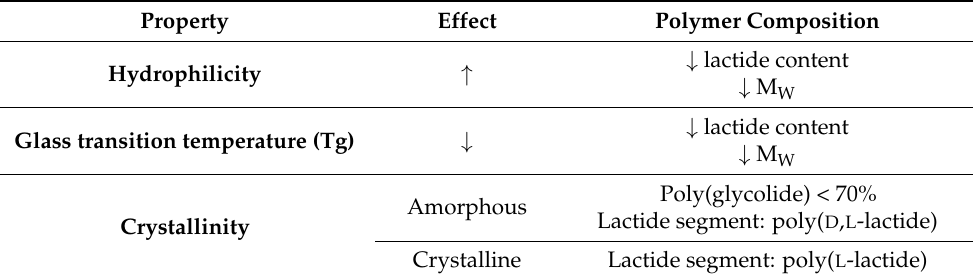
Table 1. The influence of PLGA composition on the polymer’s physical properties. Property Effect Polymer Composition ↓ lactide content Hydrophilicity ↑ ↓ M W Glass transition temperature (Tg) ↓ Amorphous Crystallinity Crystalline Lactide segment: poly( L